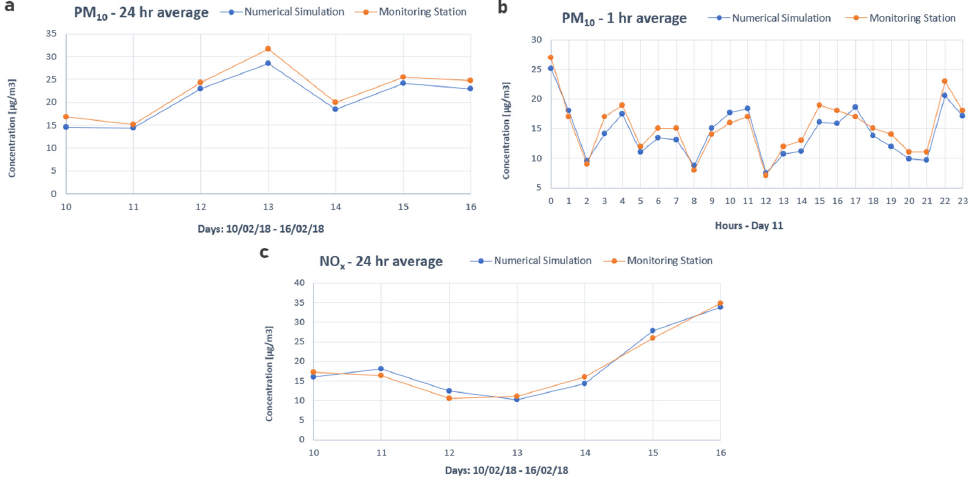
Figure 7. Timeseries of measurements (orange) [73] and present calculations (blue) for ( a ) 24 h and ( b ) 1 h average of PM10 concentration and ( c ) 24 h average of NO x concentration at Agia Paraskevi Station (Figure 4).